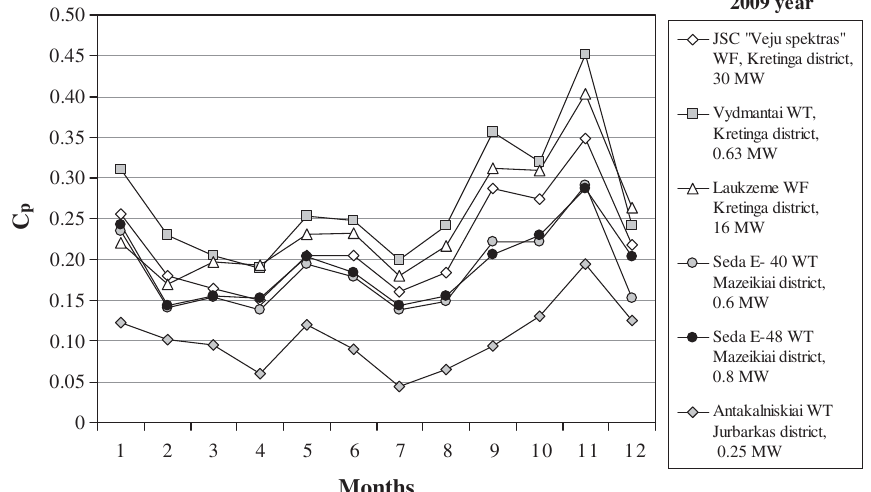
Fig. 6. Variation of capacity factor C p of separate wind turbines (WT) and wind farms (WF), operating in different regions of